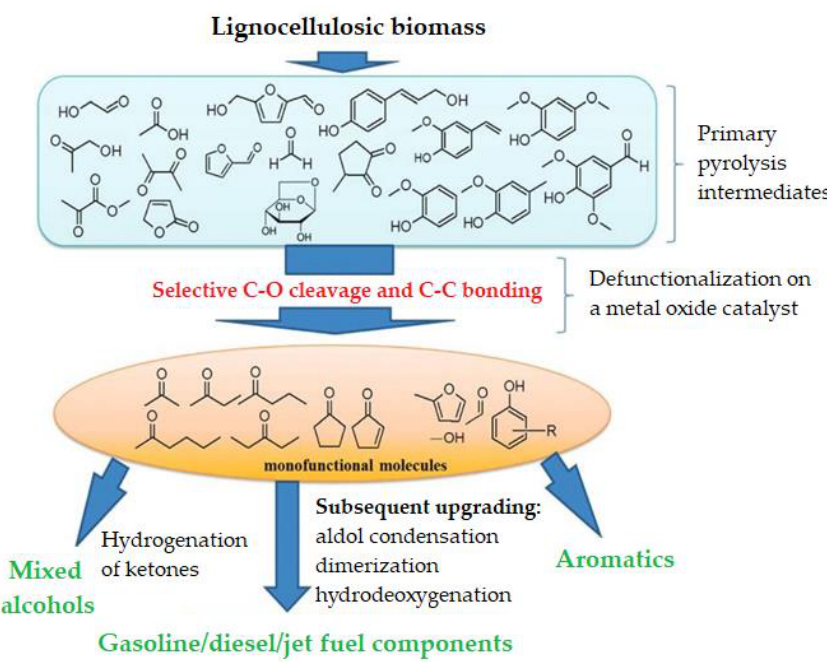
Figure 2. Biofuel production through bio-oil enhancement [50].